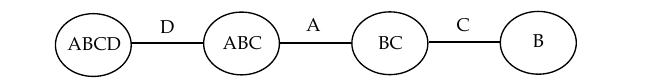
Figure A18. Tree graph for the analysis of the effect of factor B on the expected uncertainty